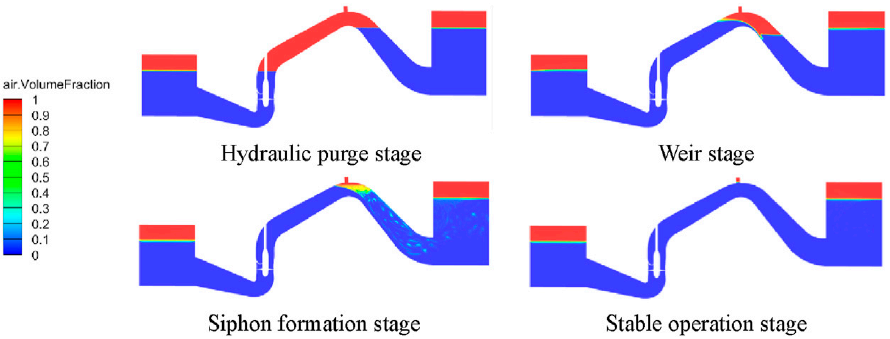
Figure 6. Stage division in the exhaust process [31].